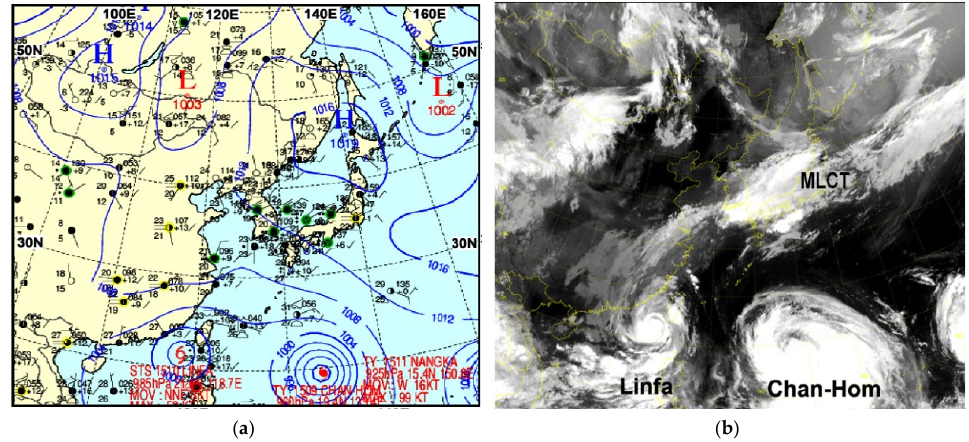
Figure 14. As shown in Figure 3, except for ( a ) surface pressure analysis (hPa), and ( b ) COMS-IR. satellite image at 09:00 LST, 8 July. STS Linfa remained stationary owing to TY Chan-Hom intensifying from interaction with TY Nangka behind but its distance to TY Chan-Hom decreased.